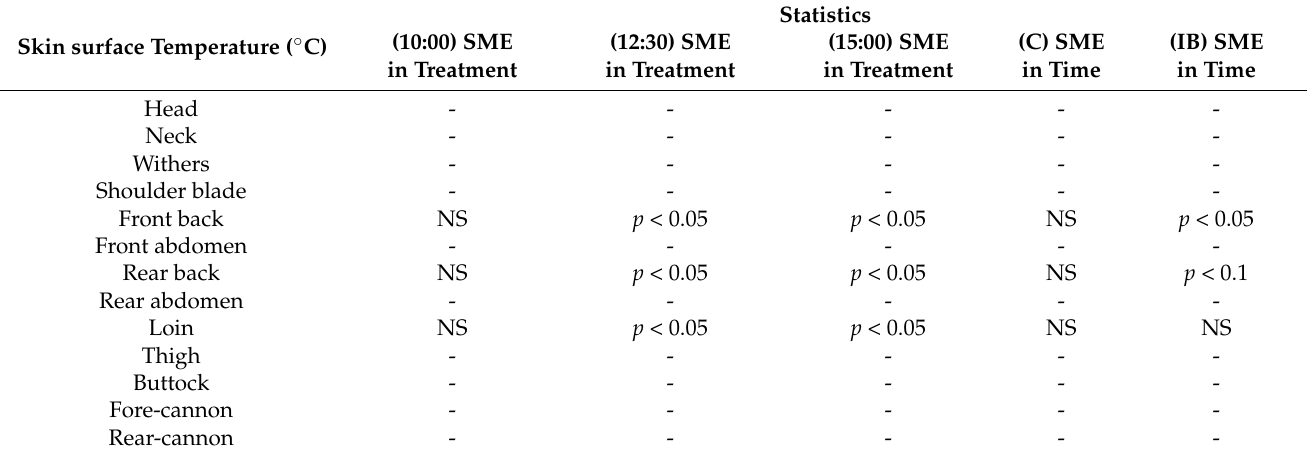
Table 5. Statistics 2 of skin surface temperature.